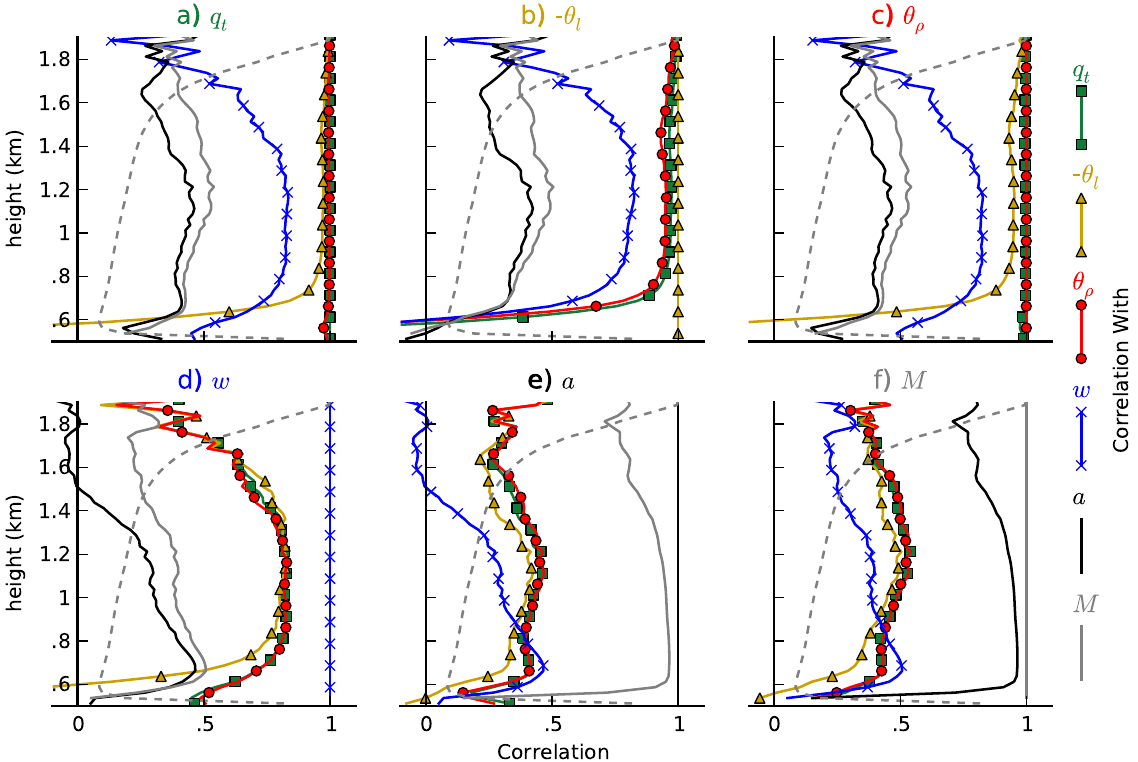
Fig. 8. Vertical profiles of cross-correlations between condensed region (a) mean total specific water q t , (b) mean liquid-water potential temperature θ l , (c) mean density potential temperature θ ρ , (d) mean vertical velocity w , (e) horizontal cross-sectional area a and (e) vertical mass flux M . Green squares denote correlations with q t , yellow triangles correlations with − θ l , red circles correlations with θ ρ , blue x markers correlations with w , unmarked black lines correlations with a , and unmarked grey lines correlations with M . The dashed line denotes the 99% confidence level for the correlation to be significantly different than